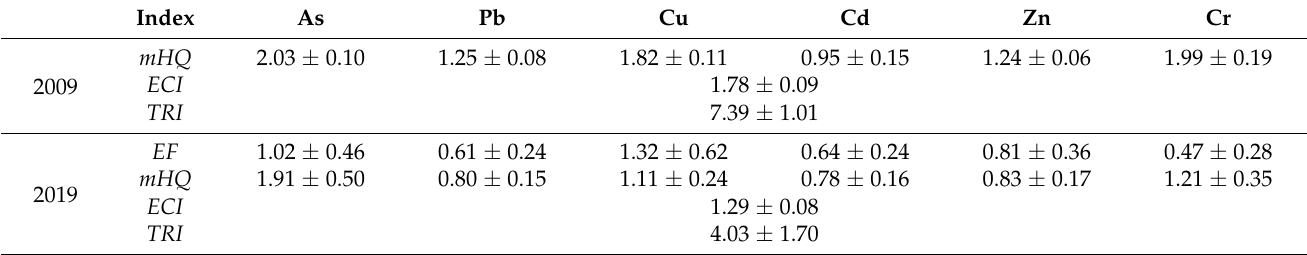
Table 3. mHQ , ECI and TRI values for heavy metals in stream sediments of Huaxi